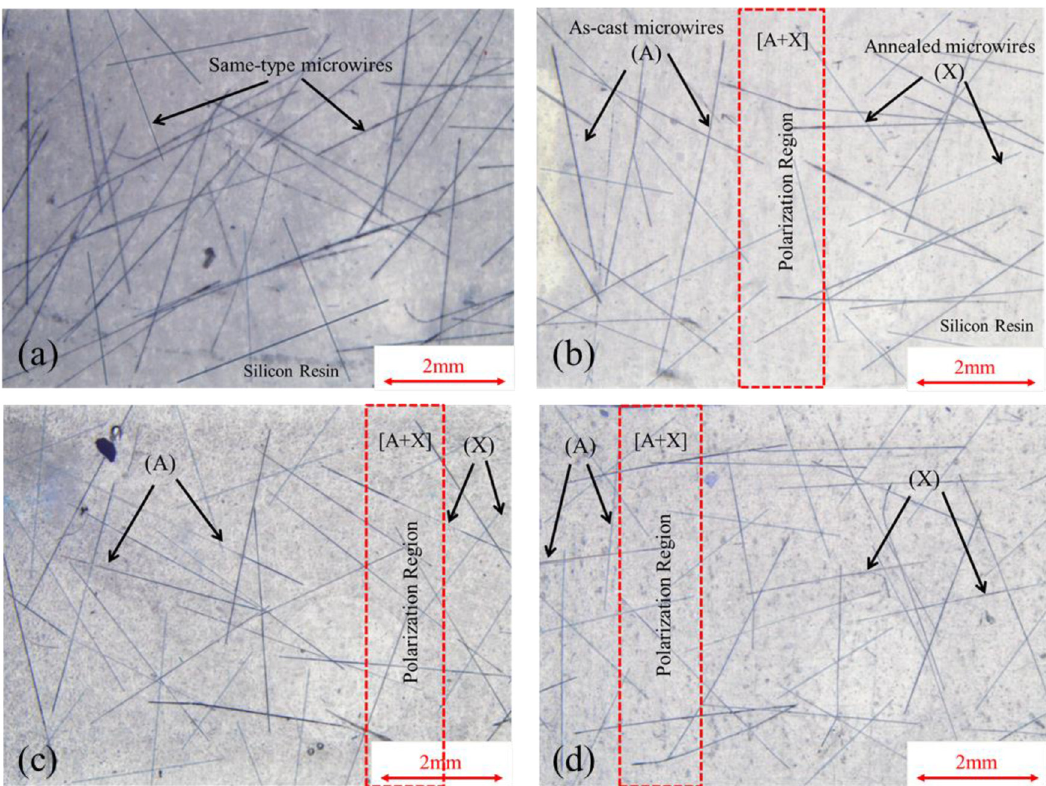
Fig. 2. Optical images of composites containing randomly distributed (a) same-type wires and (b – d) the incorporation of as-cast wires A and annealed wires X (where X corresponds to B or C annealed wires) in separate regions and different proportions. The dotted outline represents the vertical interfaces formed between the two different regions.